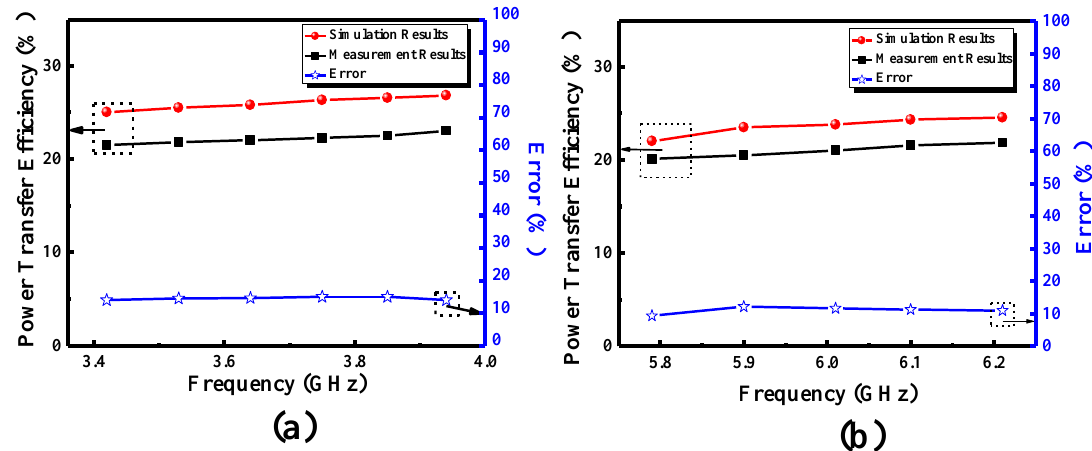
Figure 10. ( a ) The power transfer efficiency (PTE) of the MWPT system at different frequencies (four smaller side patches are all connected to the larger main patch). ( b ) The power transfer efficiency (PTE) of the MWPT system at different frequencies (one smaller side patch is connected to the larger main patch).